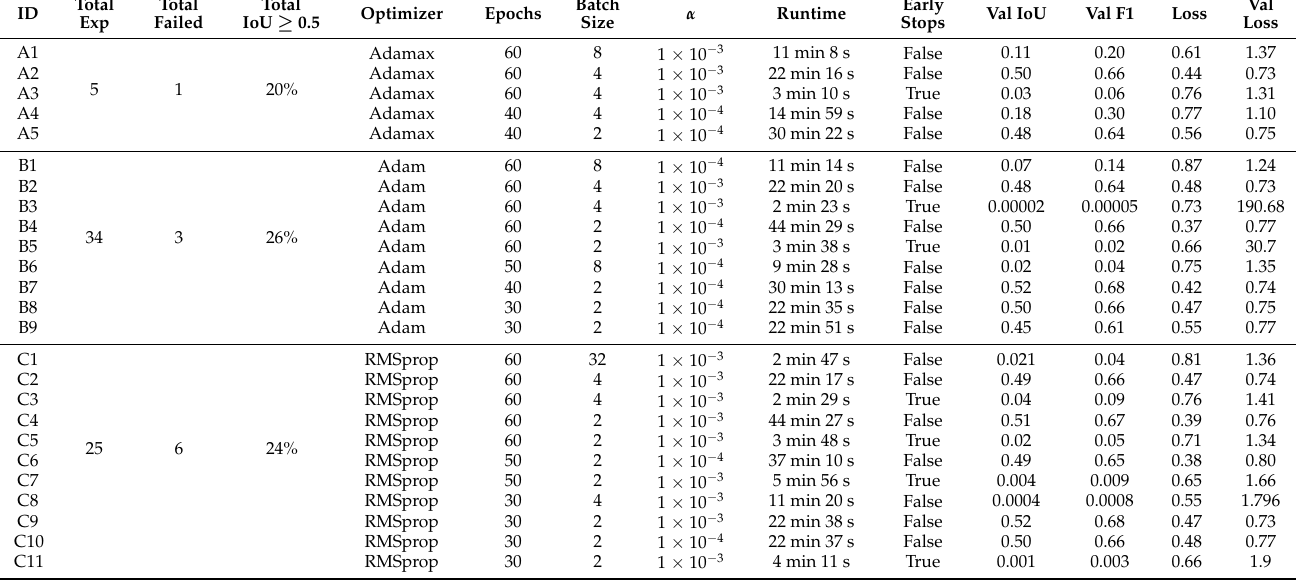
Table 4. Summary of hyperparameter BO